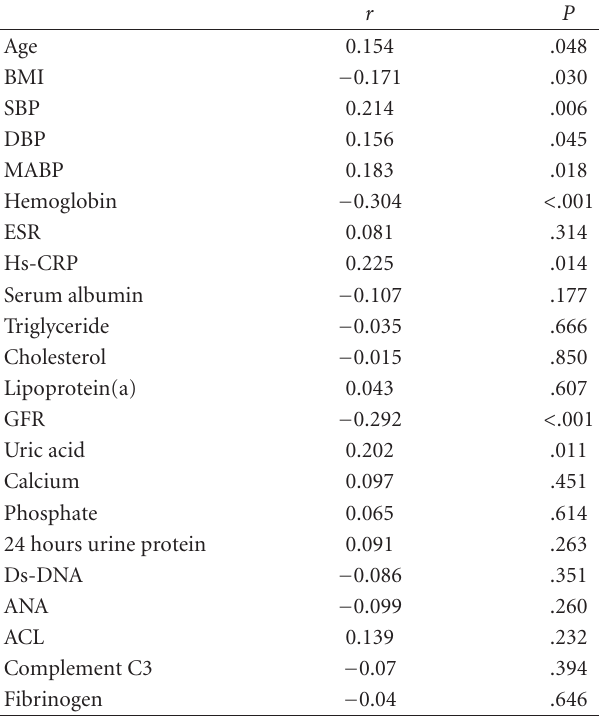
Table 3: Individual correlates of LVMI among LN